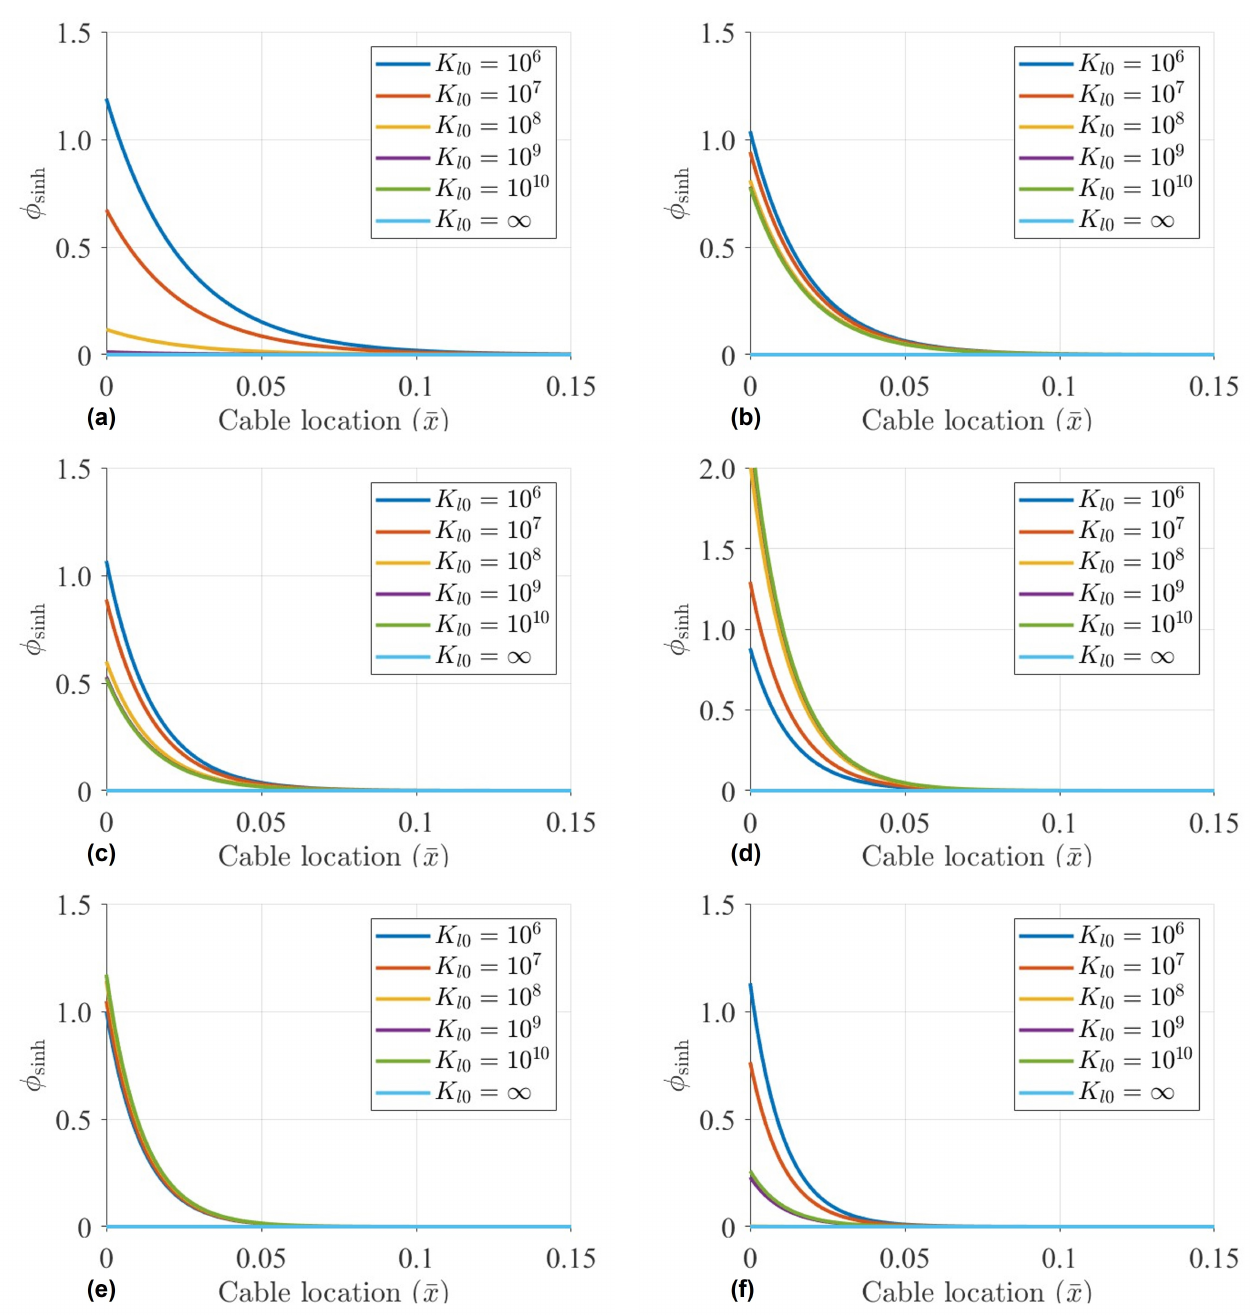
Figure 3. Influence of hyperbolic sine on vibration mode under different linear stiffness with K r 0 = 10 8 N · m and: ( a ) Mode 1; ( b ) Mode 2; ( c ) Mode 3; ( d ) Mode 4; ( e ) Mode 5; ( f ) Mode